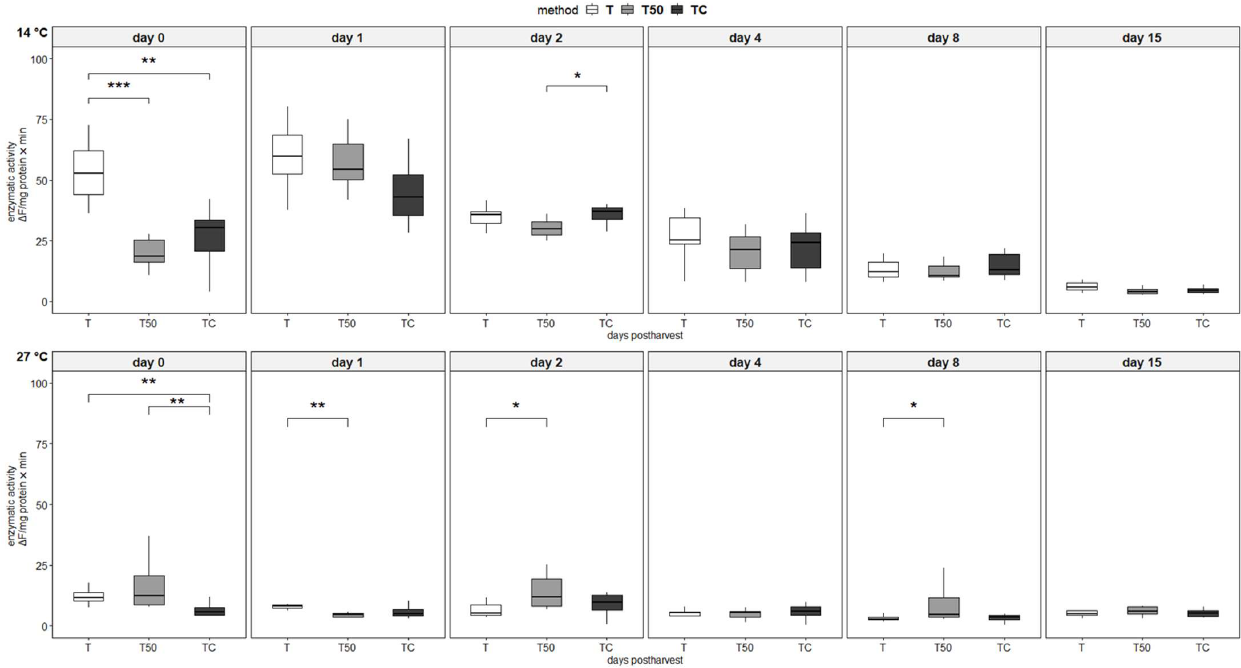
Figure 6. Collagenase activity in all tested slaughter and storage conditions. T: control group, slaughter and storage in ice flakes; T50: slaughter and storage in 1:1 slurry ice to ice flakes; TC: slaughter in slurry ice, storage in ice flakes. Enzymatic activity was expressed as fluorescence unit (FLU) change per minute per mg protein (ΔF). Superscripts: statistically significant differences between treatments on each sampling day (***: p < 0.001, ** p < 0.01, *: p < 0.05).